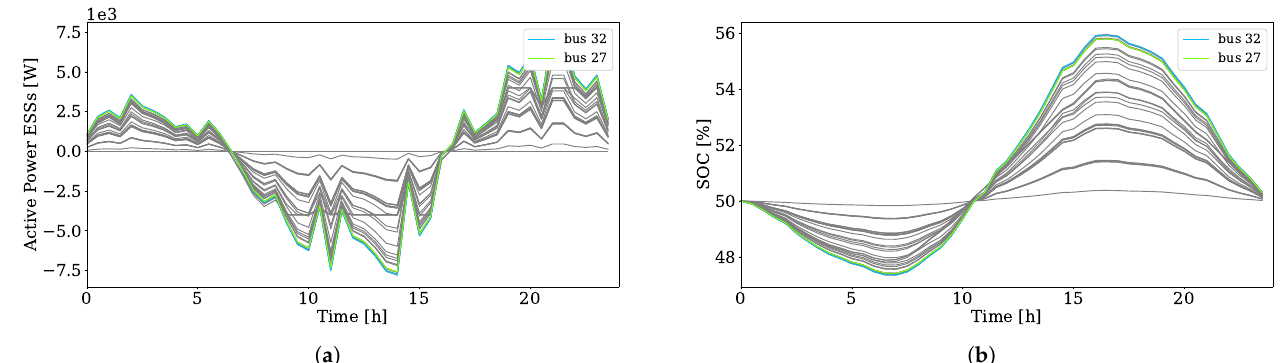
Figure 8. Result of the schedule. ( a ) Output of the schedule for active power ESSs; ( b ) output of the schedule for the SoC.